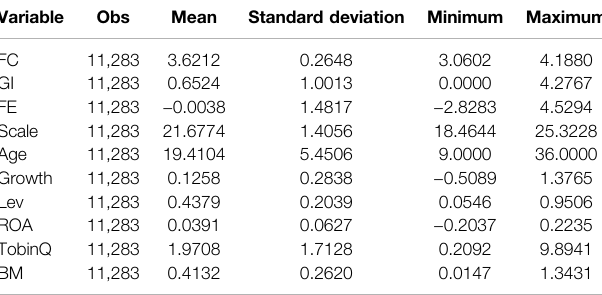
TABLE 3 | Descriptive statistics after winsorization.